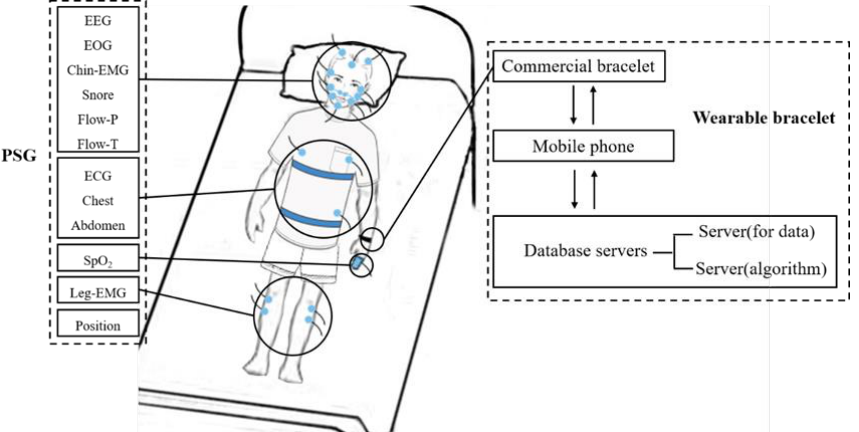
Figure 3. The experimental system diagram.